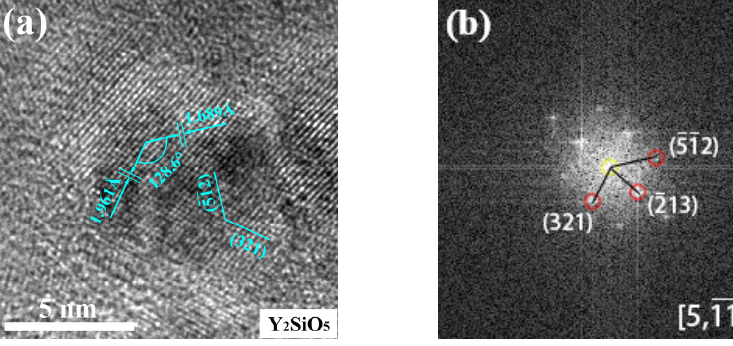
Figure 10. ( a ) HRTEM image of the Y 2 SiO 5 nanoparticle in 1280-S3 ODS steels; ( b ) FFT diagram micrograph by ( a ); ( c ) IFFT filtered image derived from three adjacent diffraction points in ( b ).